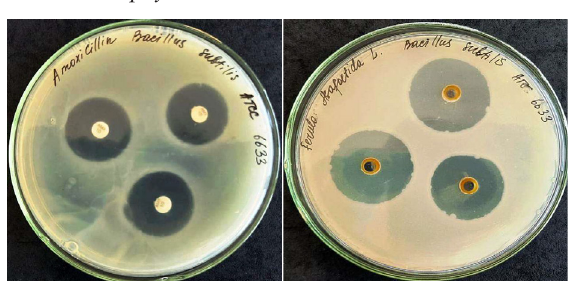
Fig. 8. Results of antimicrobial activity of CO extract 2 Ferula asafoetida L. and amoxicillin against Salmonella enterica ATCC 14028